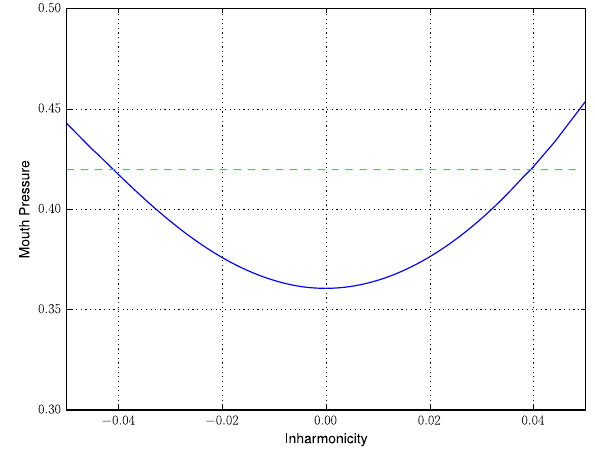
Figure 8. Minimum value of the mouth pressure c (blue line) corresponding to a stable periodic solution (fundamental regime) with respect to the inharmonicity Inh (case Z 1 < Z 2 ; in practice Z 2 / Z 1 = 3/2). Linear threshold c thr1 (green dashed line).